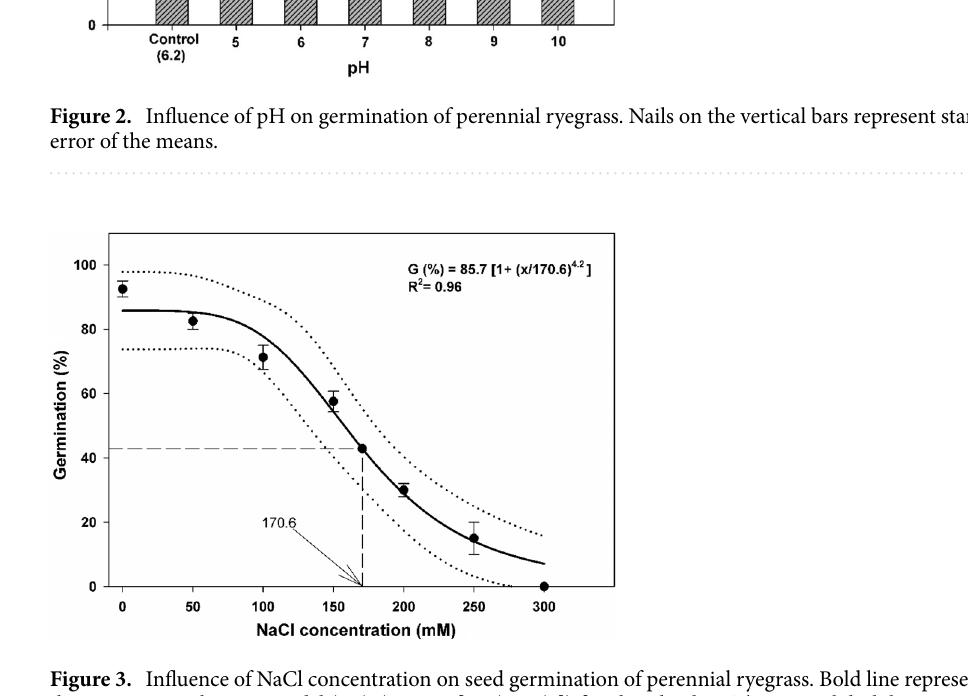
Figure 3. Influence of NaCl concentration on seed germination of perennial ryegrass. Bold line represents a three-parameter logistic model (G (%) = G max /[1 + (x/x 50 ) g ]) fitted to the data. The vertical dash line represents X-axis value at 50% of the maximum germination. Dotted liens show 95% confidence intervals. Vertical bars represent ± standard error of the mean.